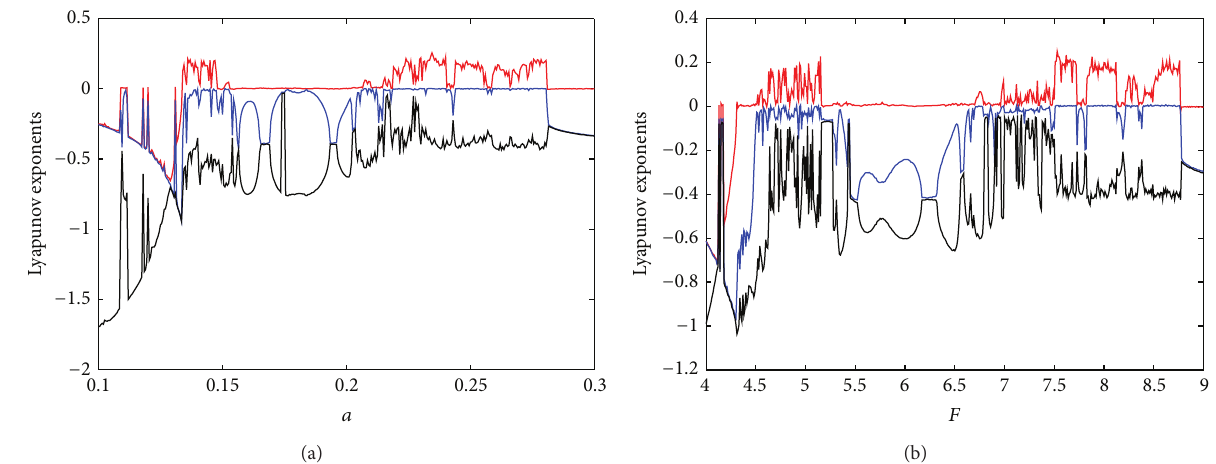
Figure 11: (a) Lyapunov exponents about 𝑎 . (b) Lyapunov exponents about 𝐹 .